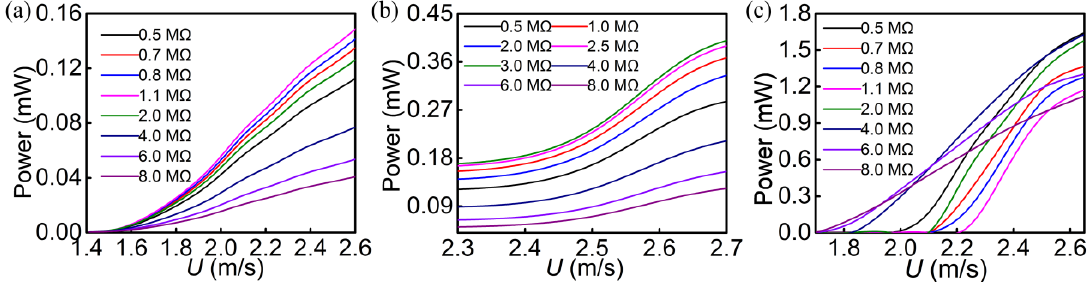
Figure 7. Numerical output power versus the wind speed: ( a ) Weak coupling k 2 /(4 ζ + 4 ζ 2 ) = 0.029; ( b ) critical coupling k 2 /(4 ζ + 4 ζ 2 ) = 1; ( c ) strong coupling k 2 /(4 ζ + 4 ζ 2 ) = 2.9.